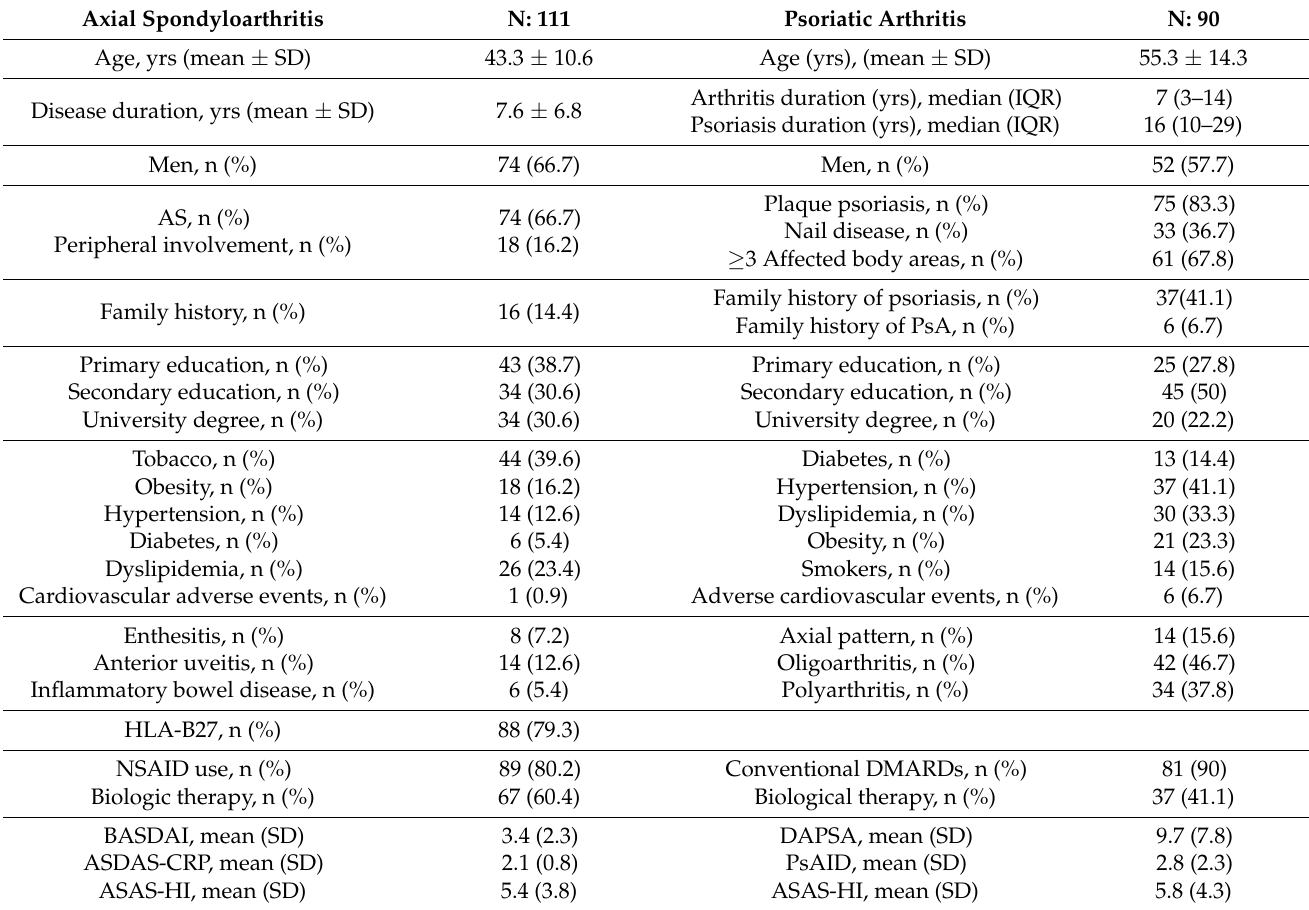
Table 1. Main disease features of both study